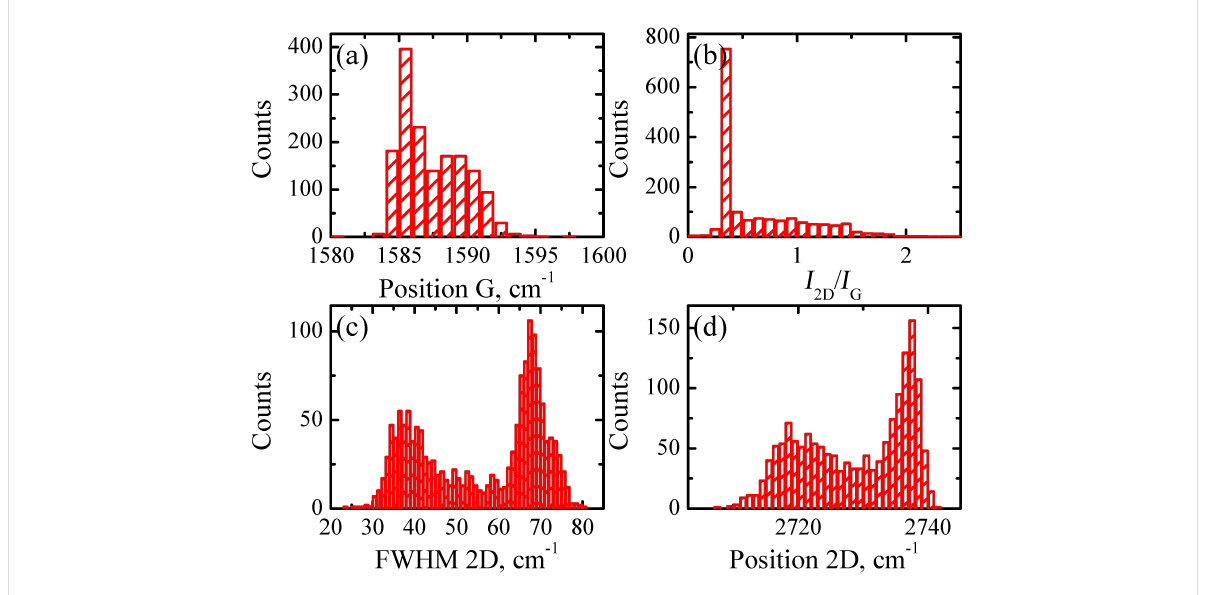
Figure 4: Raman mapping histograms for sample A on a SiO 2 /Si substrate as obtained from Raman maps of Figure 2. (a) G band position. (b) I 2D / I G . (c) FWHM of the 2D band. (d) 2D band position.